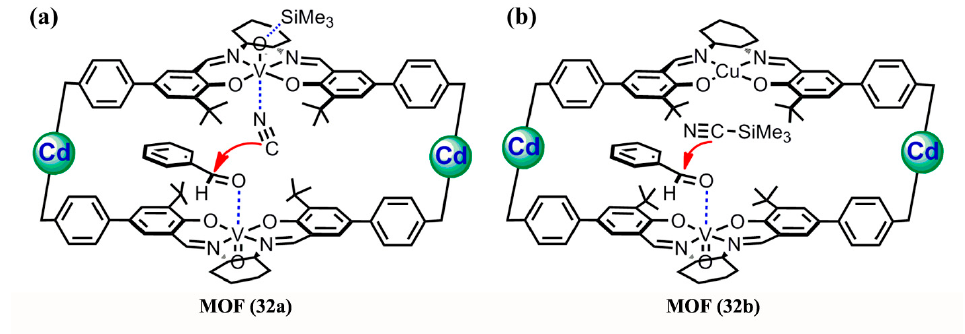
Figure 13. Proposed bimolecular ( a ) and unimolecular ( b ) activation pathways for the cyanation of aldehyde by 32a and 32b . Reproduced from [96] with permission from the American Chemical Society.